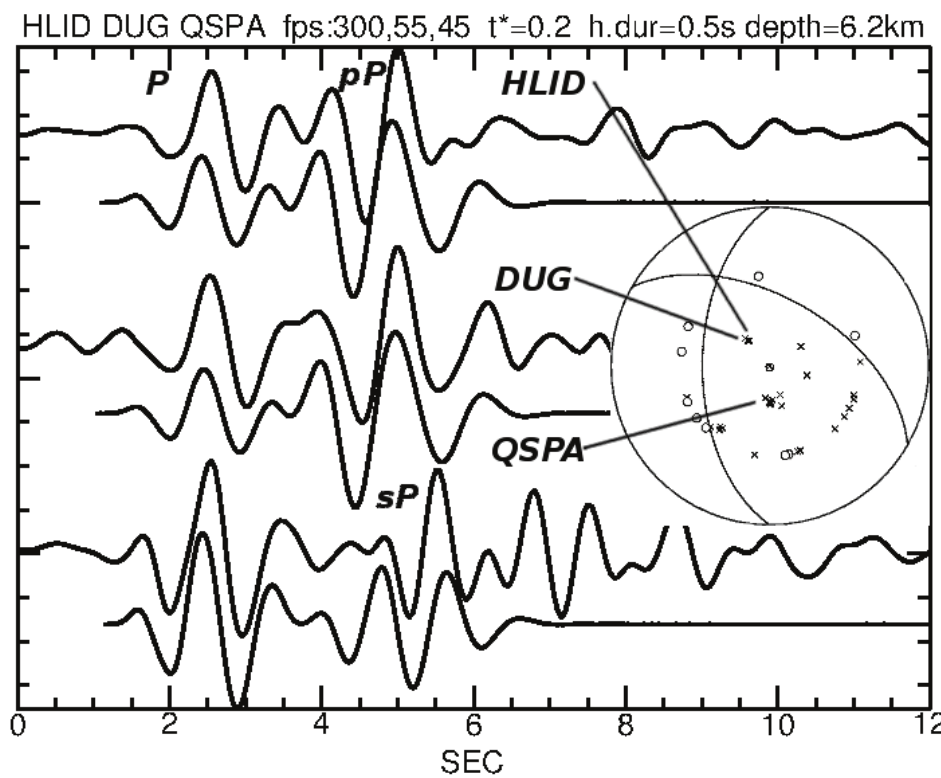
Figure 6 - Teleseismic P-wave modeling to determine the depth, with three stations (top to bottom): HLID, DUG (both in the United States) and QSPA (South Pole). The upper/lower traces are observed/calculated seismograms. Seismograms converted to WWSP response and modeled with a triangular source-time function with total duration 1.0 s and t* 0.2. The pP phase appears 2.0 s after the P, with reversed polarity and sP phase appears 4.0 s after the P in QSPA